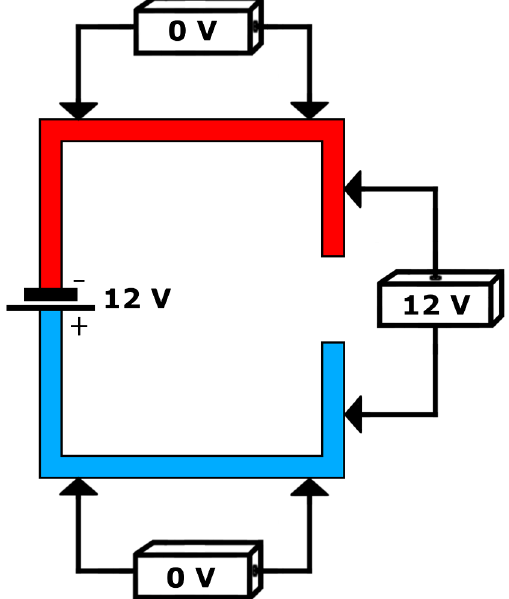
FIG. 5. Measuring of electric pressure differences with three- dimensional voltmeters.